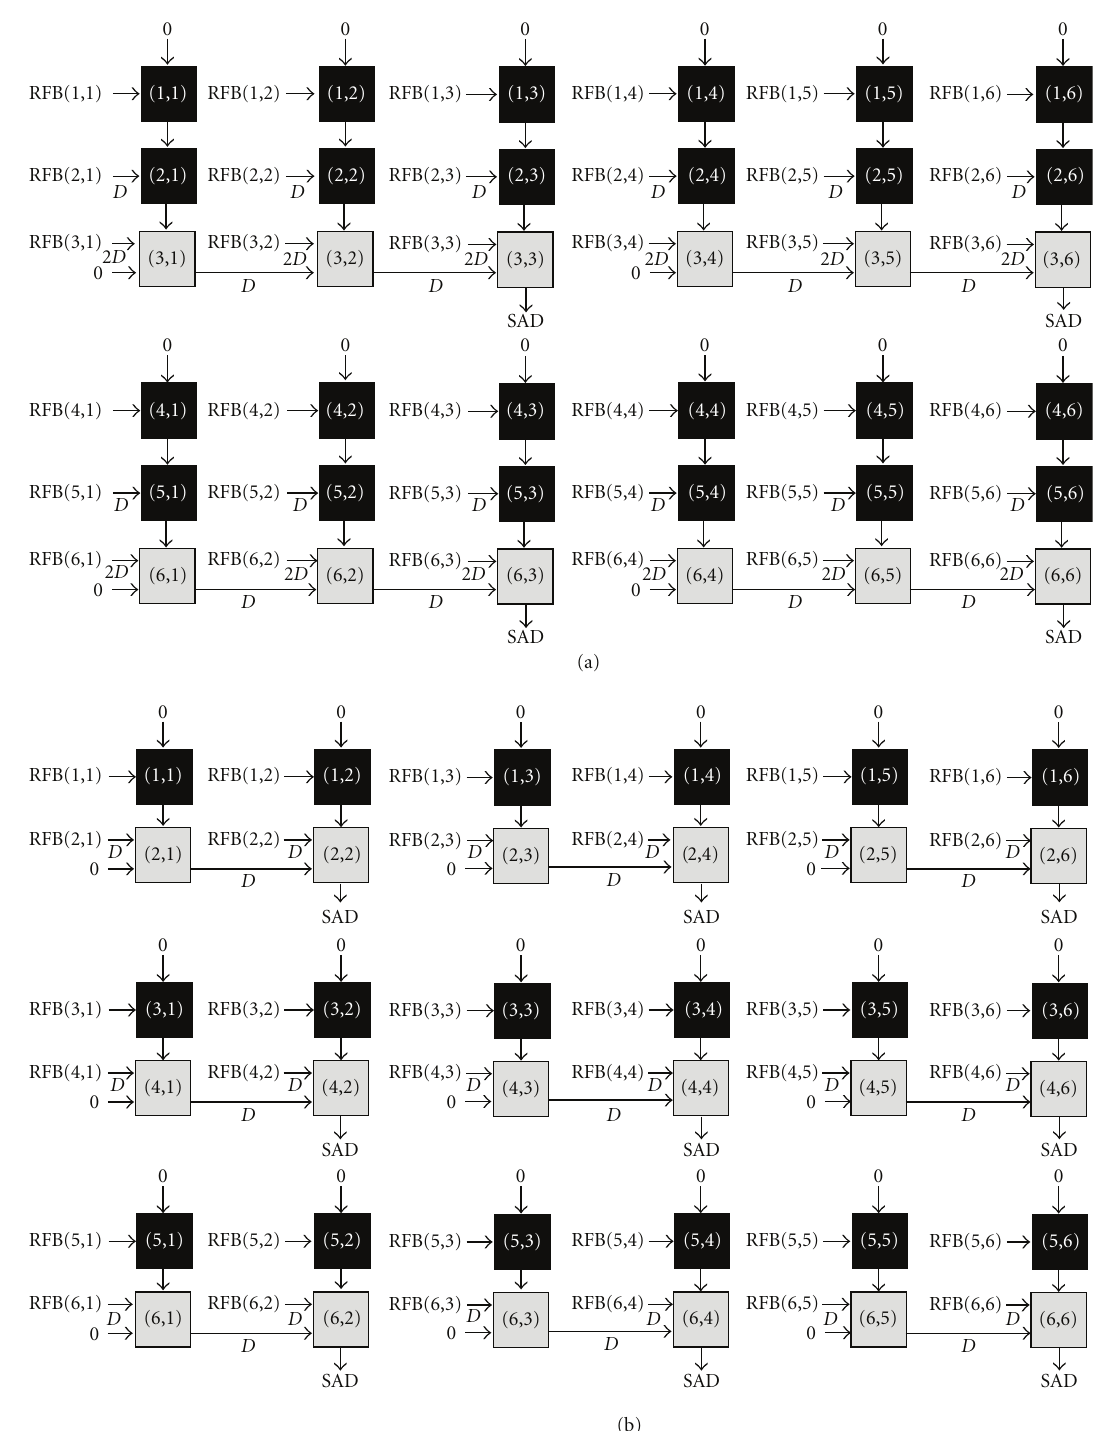
Figure 11: PESA configuration for block sizes (a) PESA1: p = q = 3 and (b) PESA2: p = q = 2 for M = N =